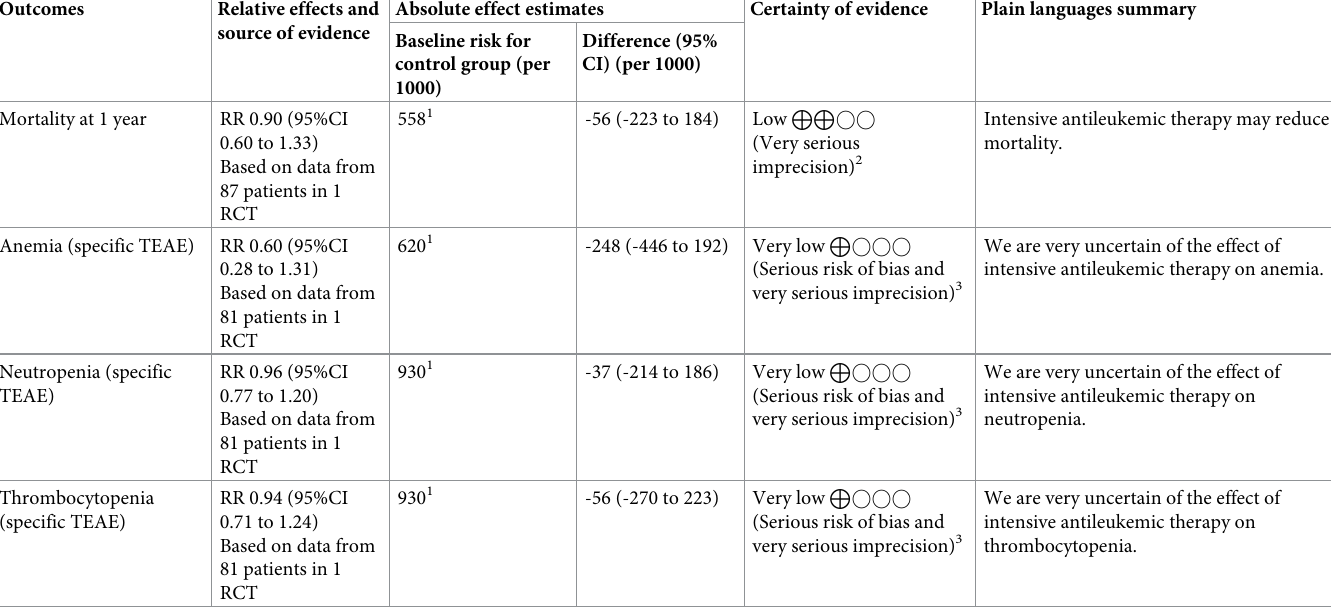
Table 3. GRADE summary of findings: Intensive versus less-intensive antileukemic therapy among older patients with acute myeloid leukemia, evidence from